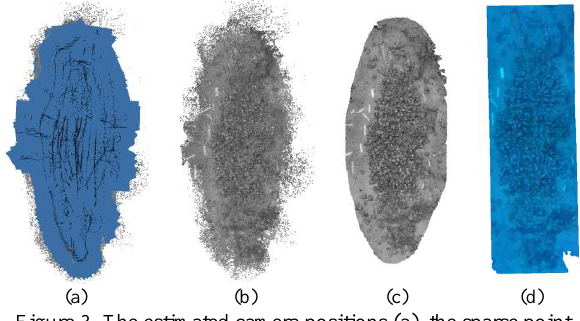
Figure 3. The estimated camera positions (a), the sparse point cloud, the dense point cloud (c) and the textured 3D model (d) of Mazotos shipwreck